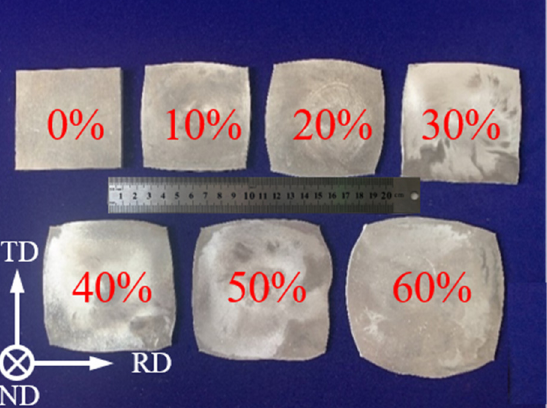
Figure 2. Deformed 5A06 aluminum alloy sheets at different CRF deformation amounts.